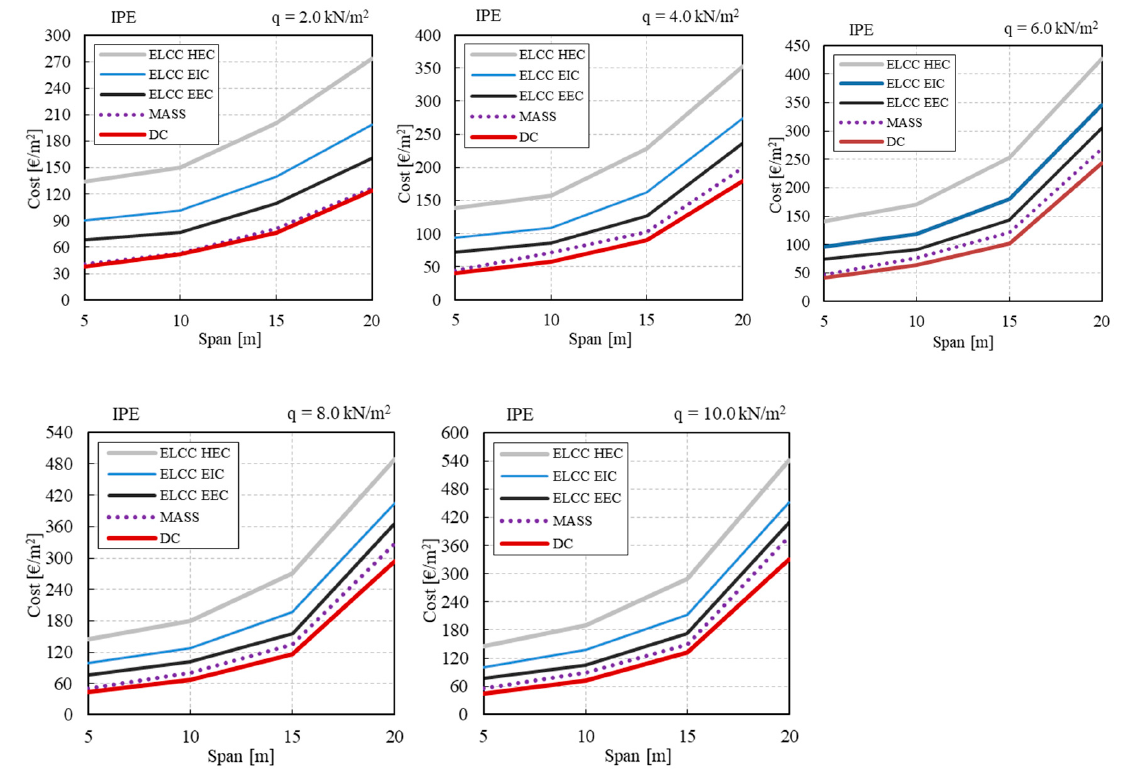
Figure 11. Diagrams of the calculated costs of the CFSIPE structures for different objective functions.